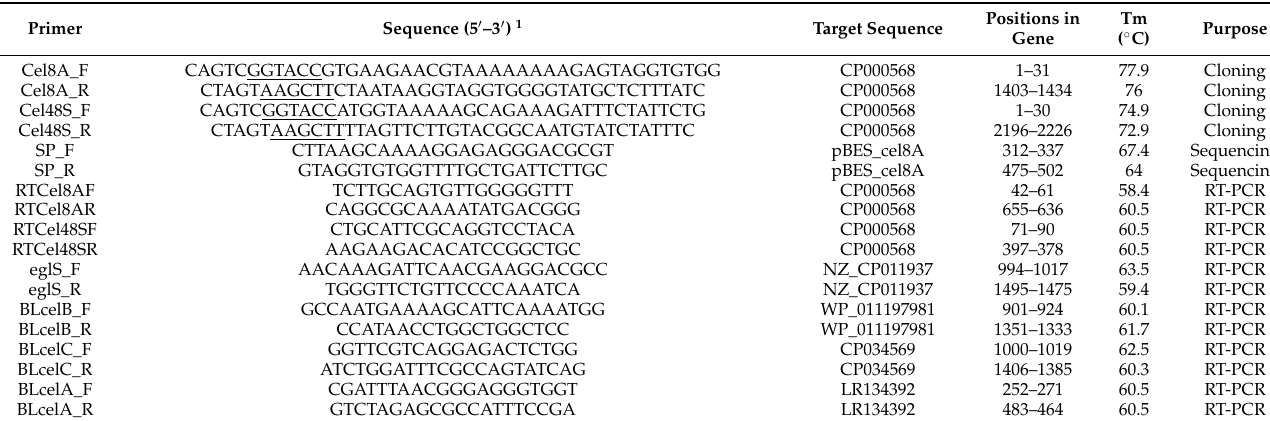
Table 3. Primers used in this